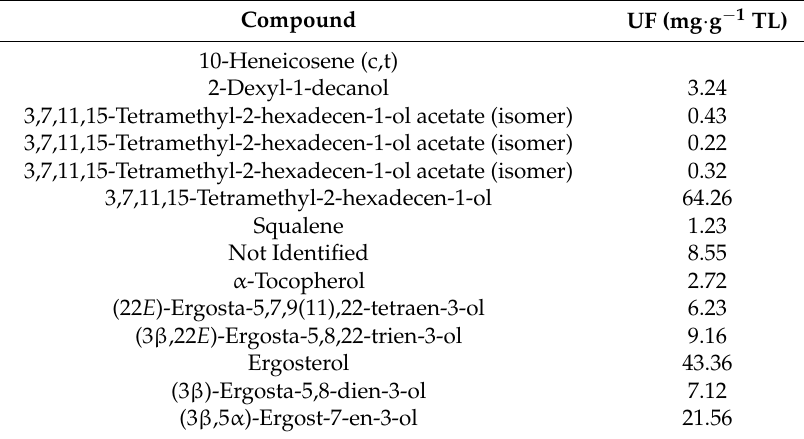
Table 1. UFs of the TL fraction extracted from Chlorella sorokiniana .